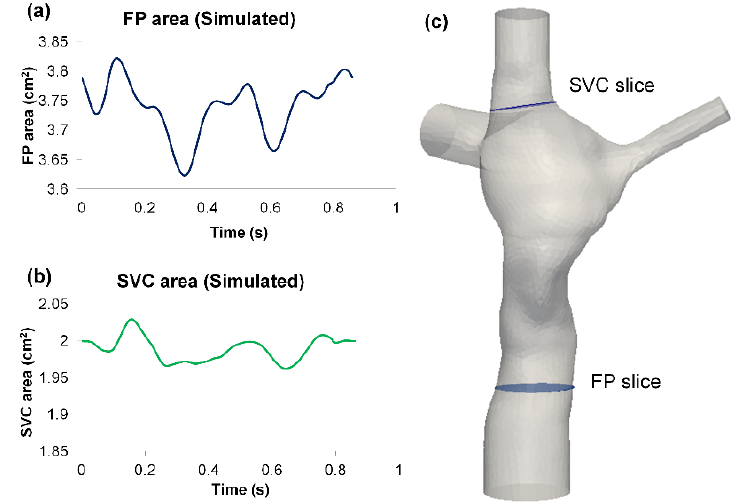
Table 3. Comparison of vessel areas between fluid-structure interaction (FSI) simulation and in vivo